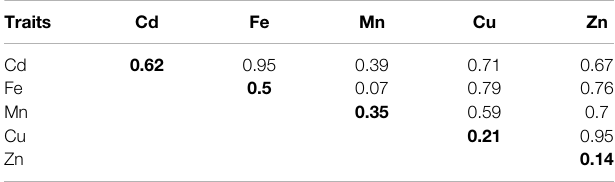
Diagonal and bold are genomic heritabilities as indicated.